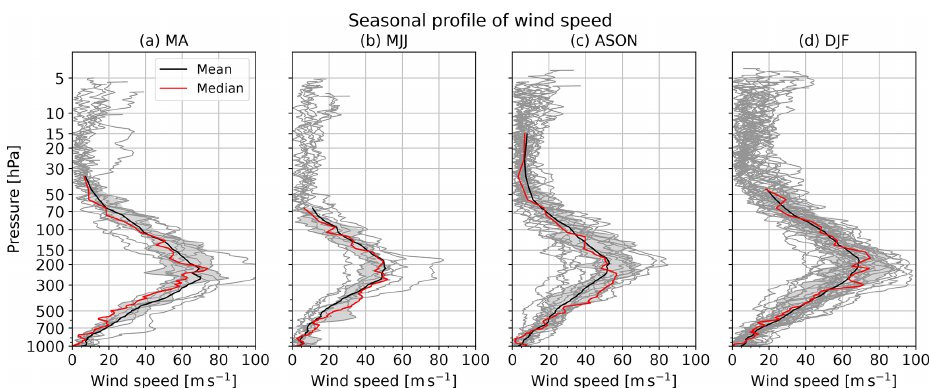
Figure 16. As per Fig. 15 but for RH.